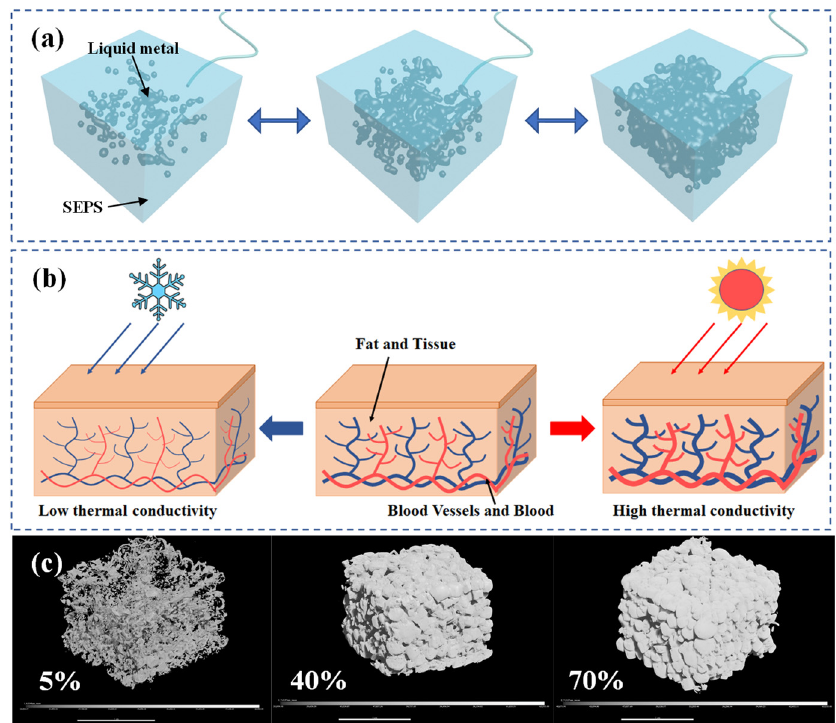
Figure 1. ( a ) B-LM-ECF regulating thermal conductivity by changing liquid metal content, ( b ) Subcutaneous tissue regulating thermal conductivity by changing blood content; ( c ) Micro-CT diagram of B-LM-ECF with 5%, 40%, and 70% liquid metal volume percentage.